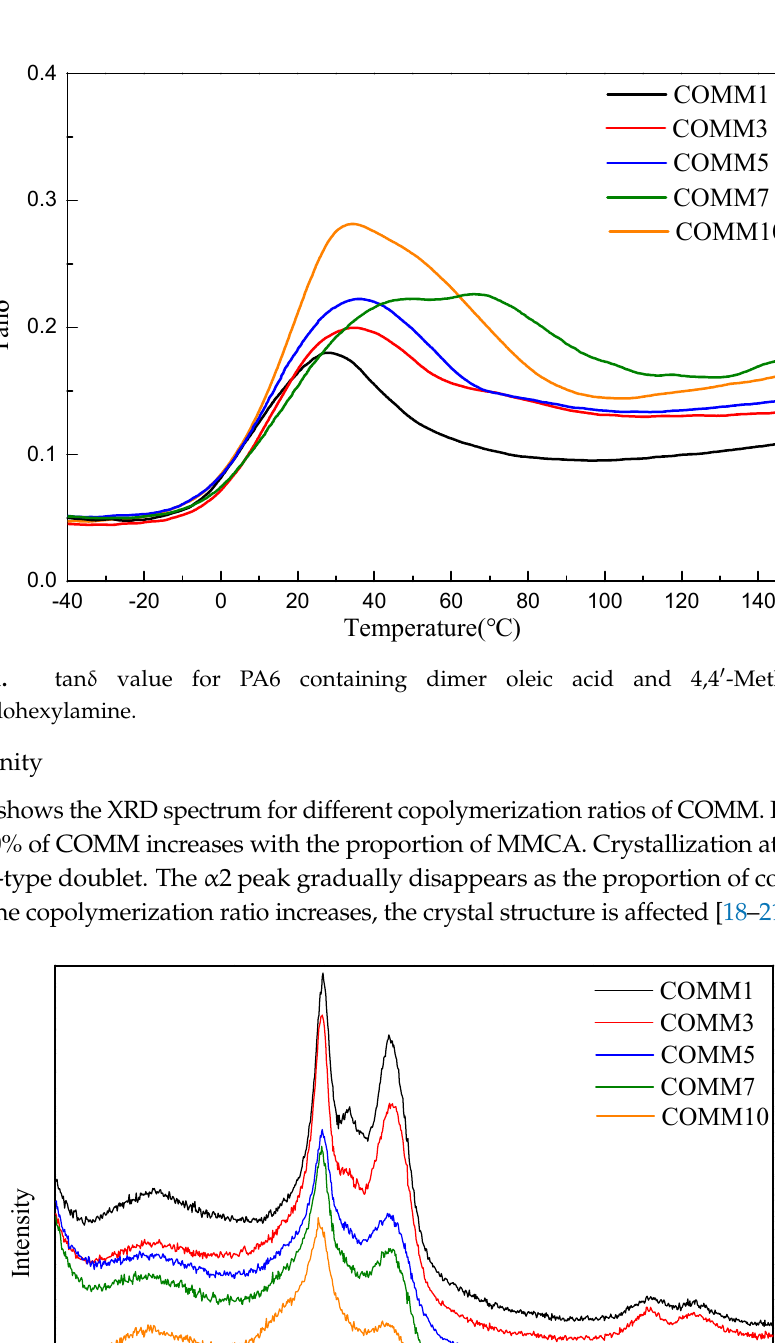
Figure 10. DMA of PA6 containing dimer oleic acid and 4,4'-Methylenebis(2-methylcyclohexylamine).